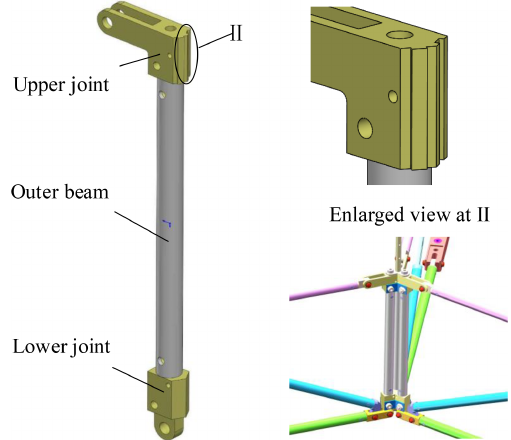
Figure 13. Outer beam